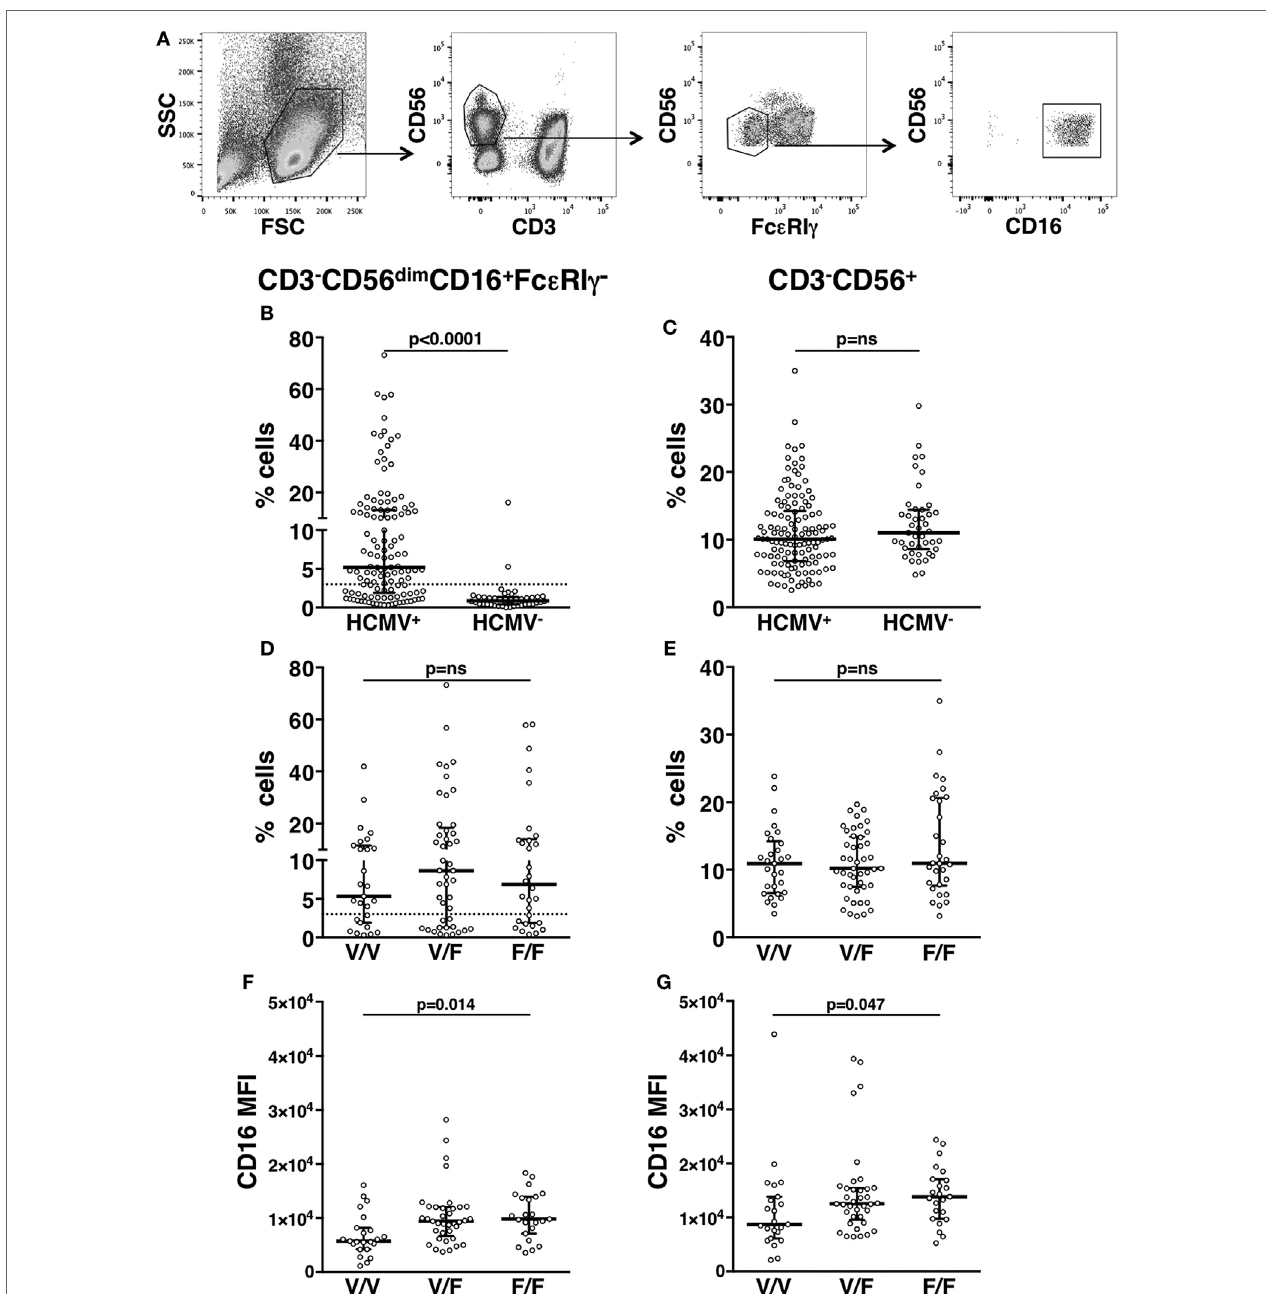
FigUre 1 | In vivo characterization of human memory natural killer (NK) cells. (a) Gating strategy for the identification of CD3 − CD56 dim CD16 + Fc ε RI γ − memory NK cells. (B) Percentage of memory NK cells (with respect to total NK cells) in the peripheral blood of human cytomegalovirus (HCMV) seropositive (HCMV + ) and seronegative (HCMV − ) healthy donors; dotted line marks the value of 3%. (c) Percentage of total CD3 − CD56 + NK cells among peripheral blood mononuclear leukocytes, in the same individuals. (D) Percentage of memory NK cells (with respect to total NK cells) in the peripheral blood of HCMV + healthy donors, stratified according to CD16 allotype; dotted line marks the value of 3%. (e) Percentage of total CD3 − CD56 + NK cells among peripheral blood mononuclear leukocytes, in the same individuals. CD16 mean fluorescence intensity (MFI) on memory (F) and total (g) NK cells of HCMV + healthy donors, stratified according to CD16 allotype. Bars represent median and 10–90 percentiles. p values of pairwise comparisons are from Mann–Whitney non-parametric test.